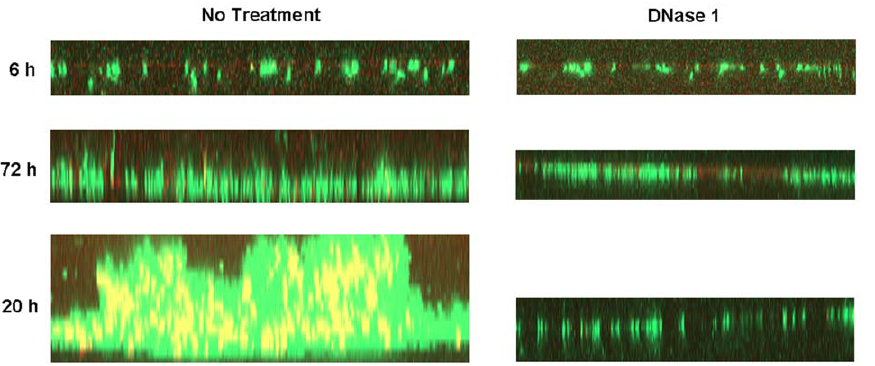
Figure 5. Susceptibility of flow cell biofilms to DNase I. Representative z-reconstructions of RB50 biofilms grown under flow conditions for 6, 72, or 120h and imaged using CLSM for live GFP expressing cells (green) and eDNA stained with DDAO (red or yellow with co-localization). The image of untreated biofilms (left panels) were taken immediately prior to incubation with DNase I and the images of same biofilms treated with DNase I for 1.5h (left panels). Images shown here are representative of two independent experiments.